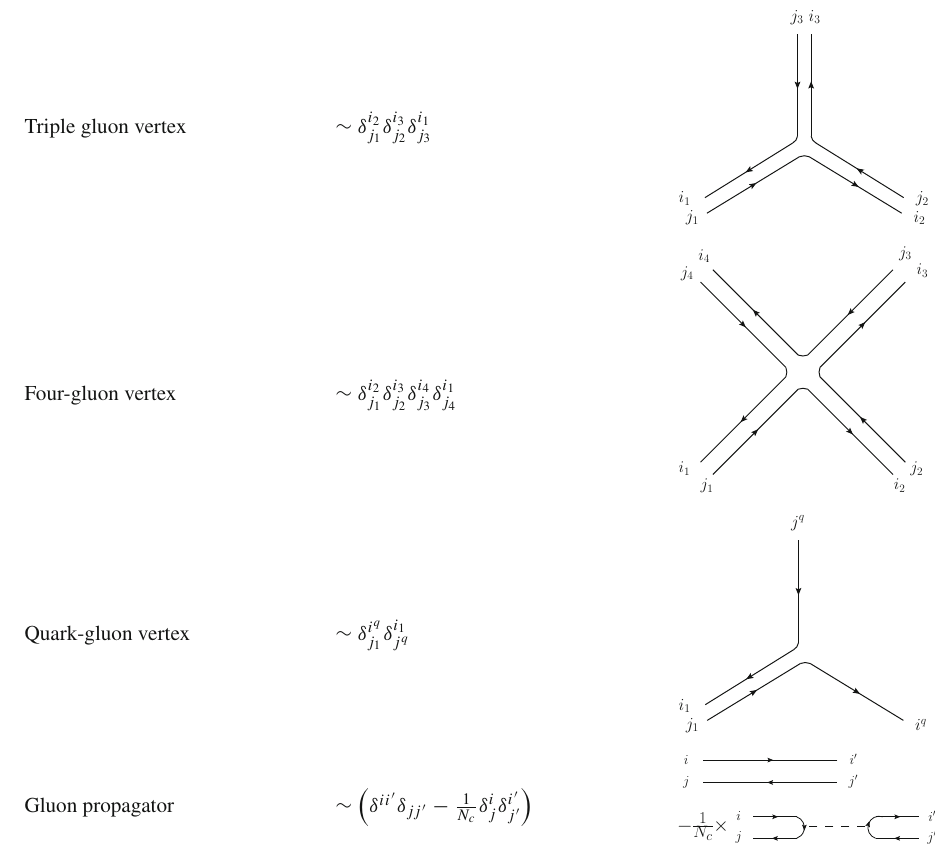
Table 1 Standard color flow Feynman rules for partial amplitudes. All momenta are outgoing. In the middle column we show the color part